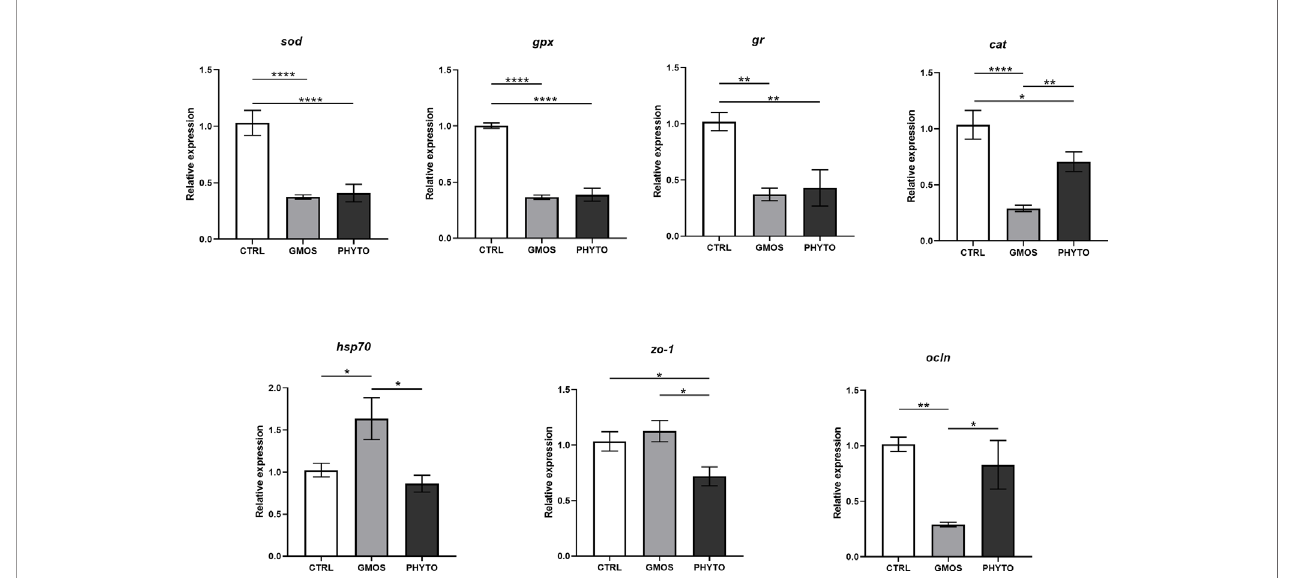
FIGURE 1 | Expression levels of genes of interest in gills of Dicentrarchus labrax samples. Diets: CTRL (control diet), GMOS (5,000 ppm galactomannan oligosaccharides), PHYTO (200 ppm phytogenic). (****p-value < 0.001, **p-value < 0.01, *p-value < 0.05; one-way ANOVA;